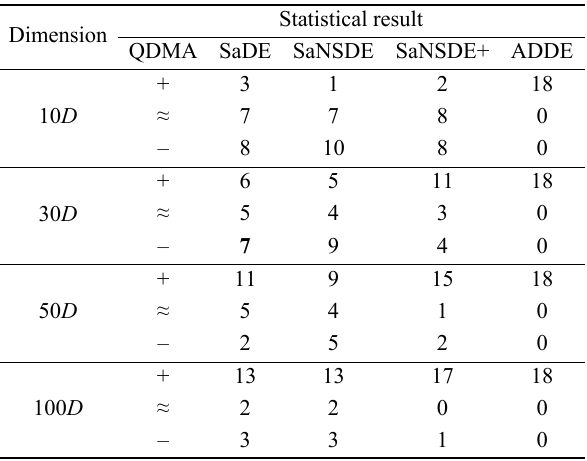
Table 5 Comparison of QDMA and state-of-the-art DE